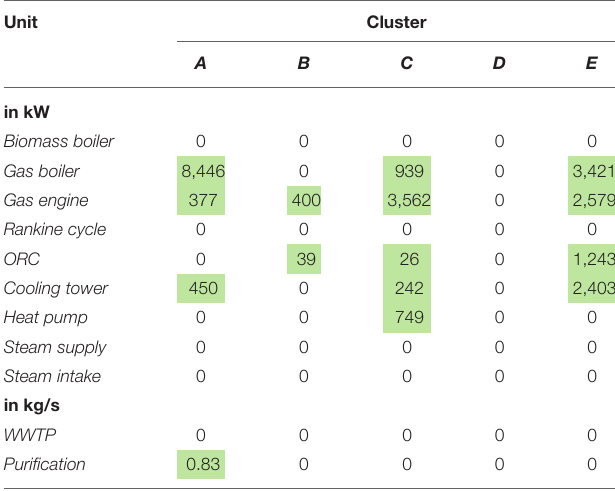
TABLE 1 | Utility unit sizing in each cluster (reference optimization).